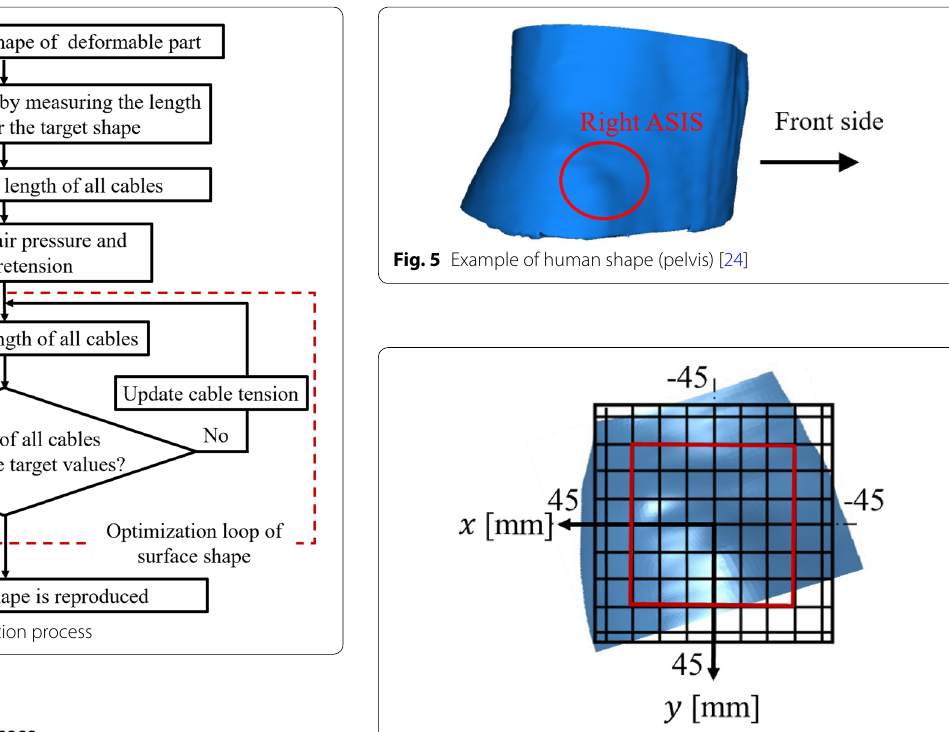
Fig. 6 Human shape reproduction area and coordinates